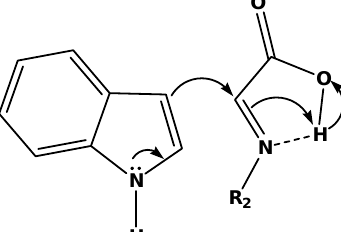
Figure 1. Intramolecular acid catalysis of the Friedel-Crafts reaction of indole with an